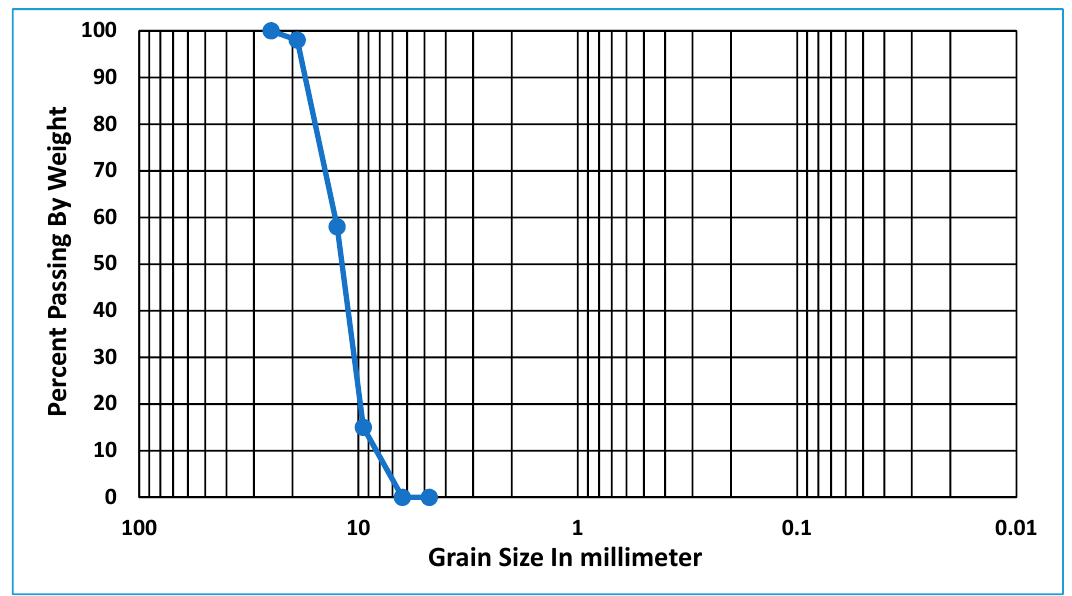
Grain Size In millimeter Figure 2. Gradation curve of Figure 2. Gradation curve of aggregates.